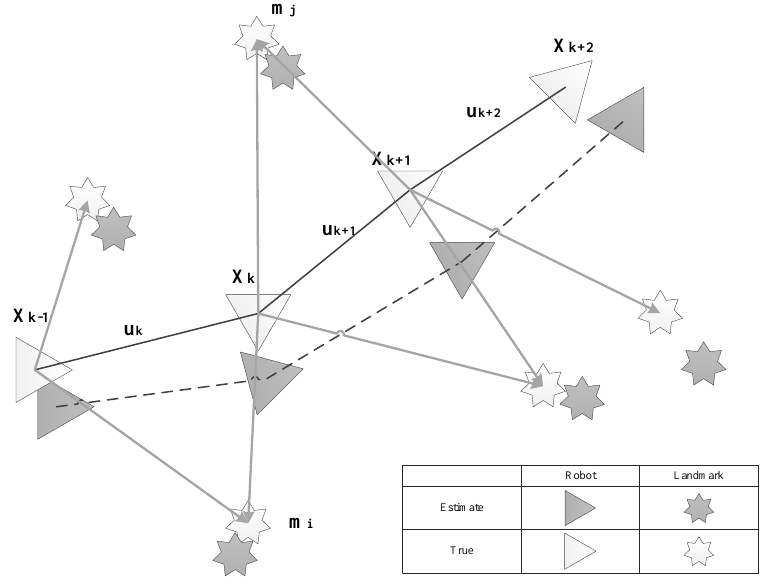
Figure 8. The SLAM problem quantified into different